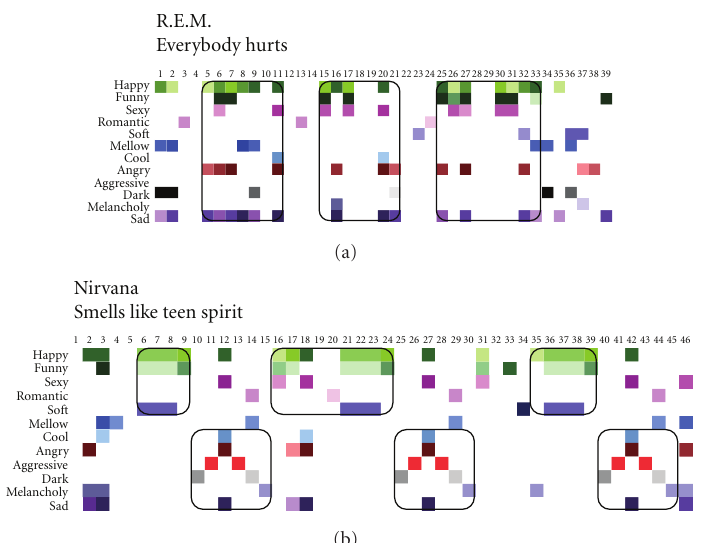
Figure 9: Pairwise comparison of patterns reflecting LSA correlation values in the lyrics of the songs (a) “Everybody hurts”, and (b) “Smells like teen spirit” against 12 a ff ective terms.